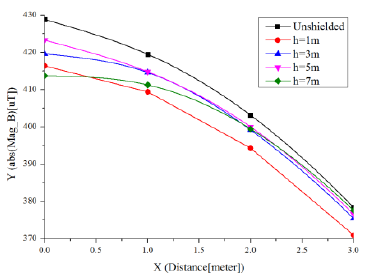
Figure 11. Shielding effect of different heights.